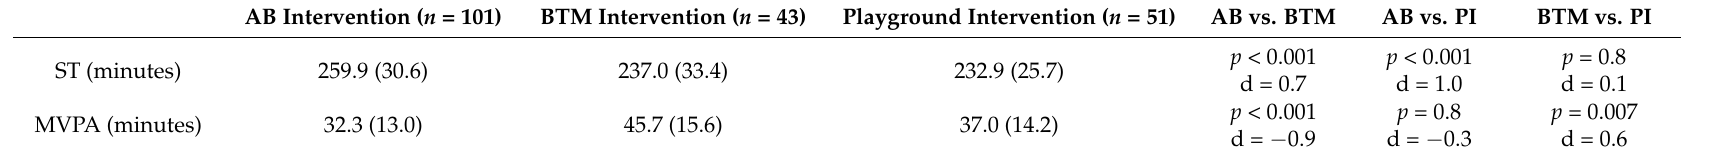
p < 0.001 p < 0.001 p = 0.8 d = 0.7 d = 1.0 d = 0.1 p < 0.001 p = 0.8 p = 0.007 d = − 0.9 d = − 0.3